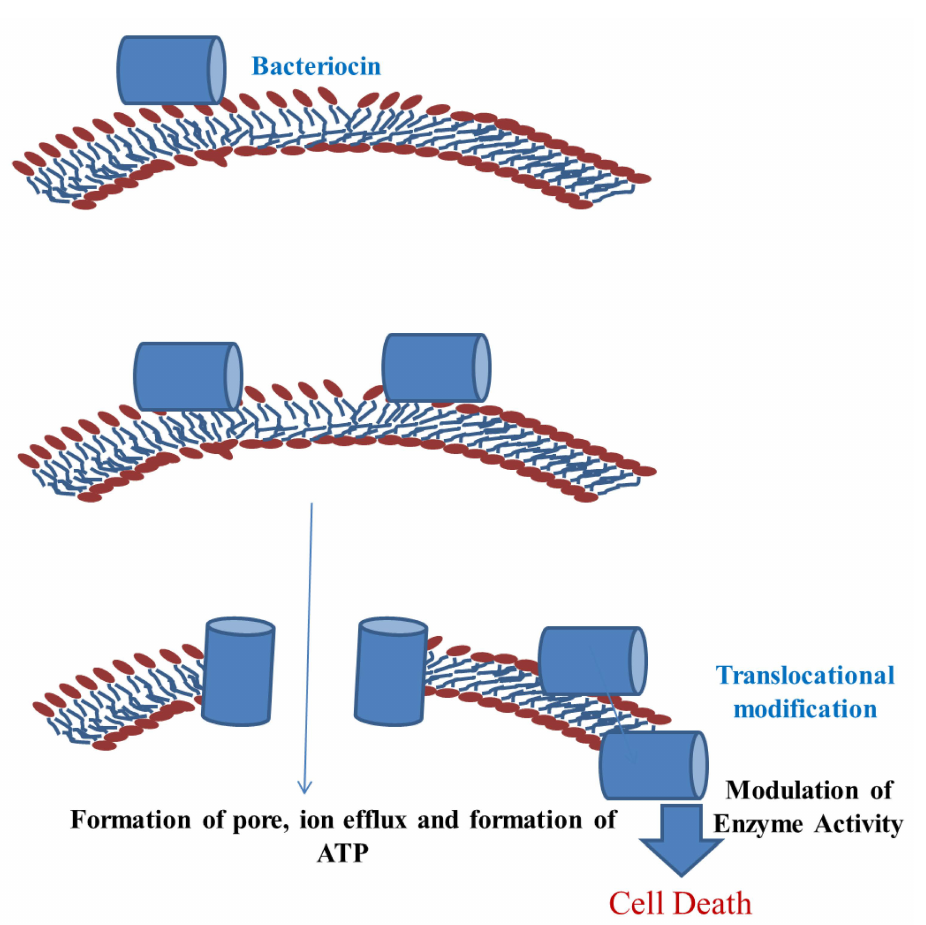
Figure 3. Mechanism of inhibiting the pathogenic cells responsible for meat